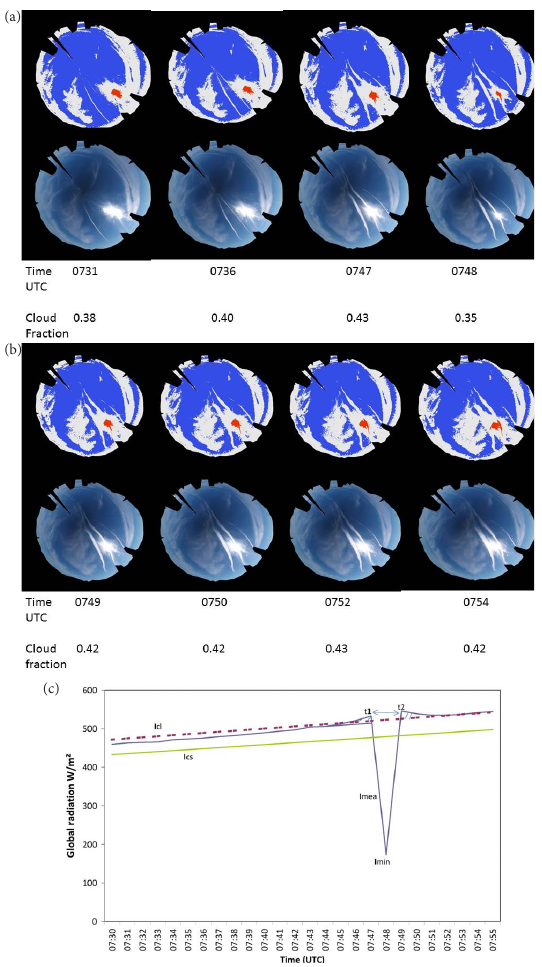
Figure 1. (a – c) Sequence of fish-eye photographs before and after a sun obstruction event by a contrail. The upper panel shows the photographs analysed by the software findcloud (CMS Schreder) which differentiates between cloud and clear sky pixels and deter- mines the cloud fraction. (a) shows the photographs from 07:31, 07:36, 07:47 and 07:48UTC (when the contrail moves between sun and observer), (b) shows photographs after the obstruction event. Below the photographs the time of the photograph and cloud frac- tion determined by the software findcloud is shown. The difference and the variations of the cloud fraction determined before and after the obstruction event (cloud fraction between 0.38 and 0.43) com- pared to the cloud fraction determined during the obstruction event (0.35) shows an uncertainty introduced by the dome of the fish-eye camera. (c) shows the global radiation which corresponds to the time of the photographs. Global radiation (blue line), cloudless ref- erence I cs (green line), interpolated global radiation I cl (red dotted line) during an obstruction event by a contrail. (07:30 to 07:55UTC, 23 September 2010). Due to surrounding (reflecting) clouds caus- ing an increase in diffuse radiation the global radiation is higher as compared to cloudless conditions.The arrows show the duration of an obstruction event which has an uncertainty of 1min (related to the measurement interval of 1min).